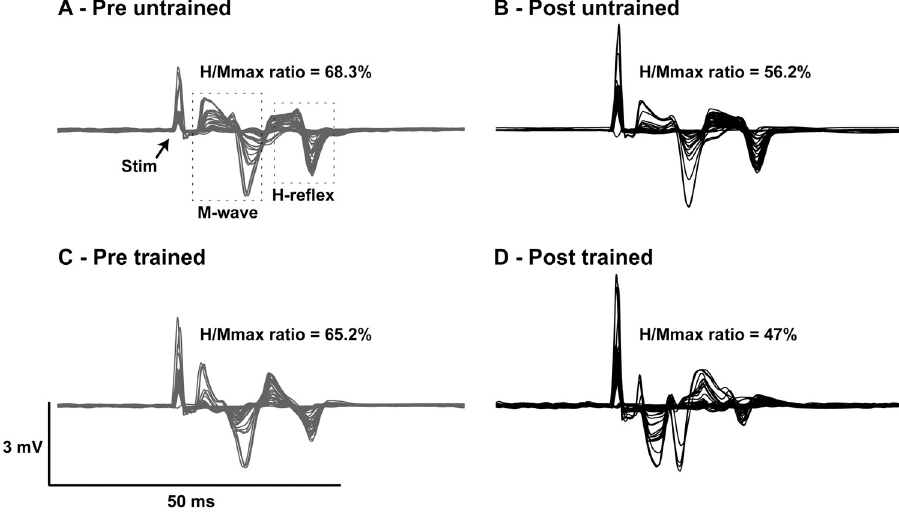
Fig 4. Individual EMG records for each stimulation pulse (n = 40) are shown for a participant’s pre (left; black) and post (right; grey), and untrained (top) and trained (bottom) FCR M-wave and H-reflex recruitment curves. All traces are overlaid and H max /M max ratios are indicated for the trial as a percent of M max